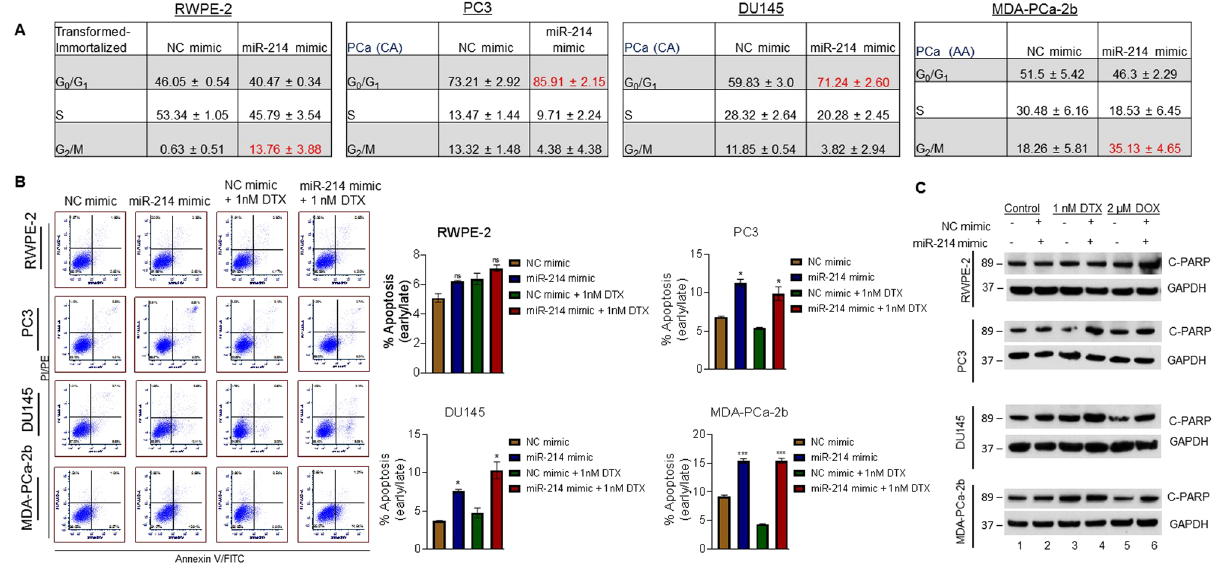
Figure 2. Effects of miR-214 overexpression on cell cycle progression and apoptosis. (A) RWPE-2, PC3, DU145, and MDA-PCa-2b cells were transfected with NC or miR-214 mimic. The percentages of cells in the G 0 / G 1 , S, and G 2 /M cell cycle phases for each cell line are shown. The red numbers indicate a significant increase in cell cycle phase in the miR-214-transfected cells compared to NC-transfected cells. B) RWPE-2, PC3, DU145, and MDA-PCa-2b cells were transfected with NC or miR-214 mimic with and without 1 nM docetaxel (DTX). Flow cytometry was used to determine the percentages of Annexin V-FITC + cells (right lower quadrant, early apoptosis) and Annexin V-FITC + /PI + cells (right upper quadrant, late apoptosis). Representative plots (left) and the corresponding quantification (right) are shown. C) RWPE-2, PC3, DU145, and MDA-PCa-2b cells were transfected with NC or miR-214 mimic. Cells were also treated with DTX or doxorubicin (DOX). The effects of miR-214 mimic alone or in combination with the drugs above on C-PARP and GAPDH expression were analyzed by western blotting. One-way ANOVA with Tukey’s multiple comparisons test was used to determine statistical significance. The data represent mean ± SEM and results are representative of three independent experiments * P < 0.05, *** P <